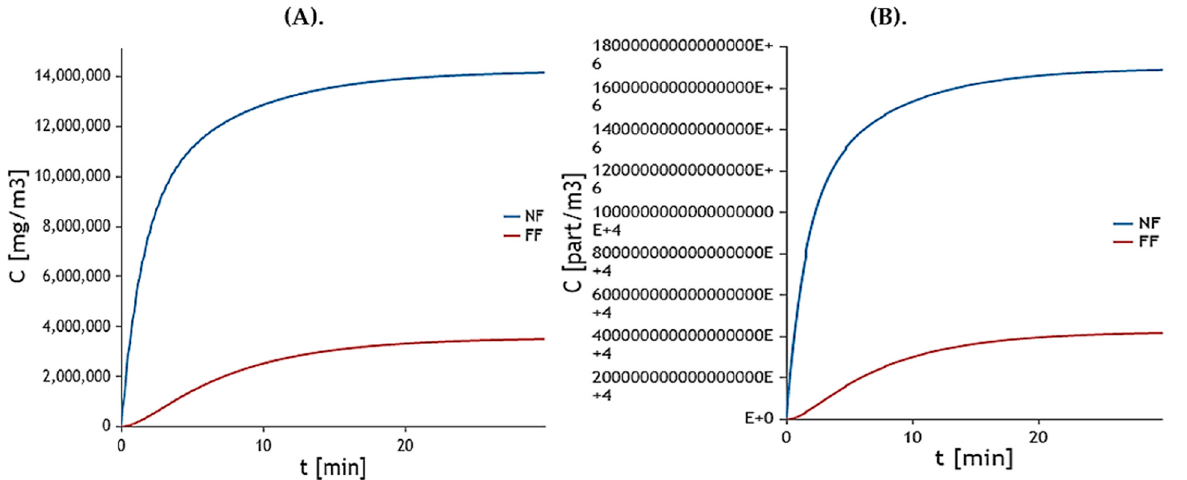
Figure 13. Mathematical model of thermal conductivity of ZVI-NPs at a particular temperature range of (15–40 °C) along with the solvent mixing at 1:1, 1:2, 1:4, and 1:6.